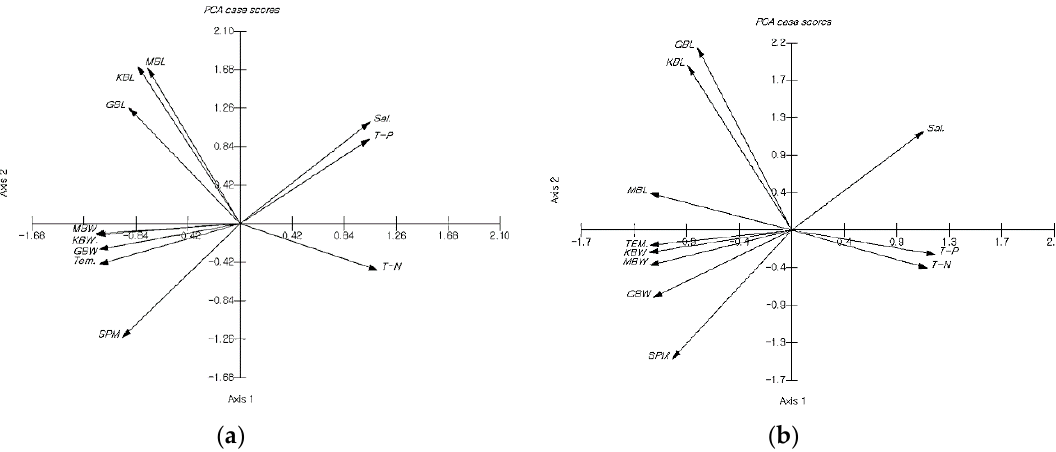
Figure 5. Plots of principal component scores for morphological and habitat characteristics of U. pinnatifida between January and May 2003. ( A ) Myeongcheon aquafarm; ( B ) Gyedo